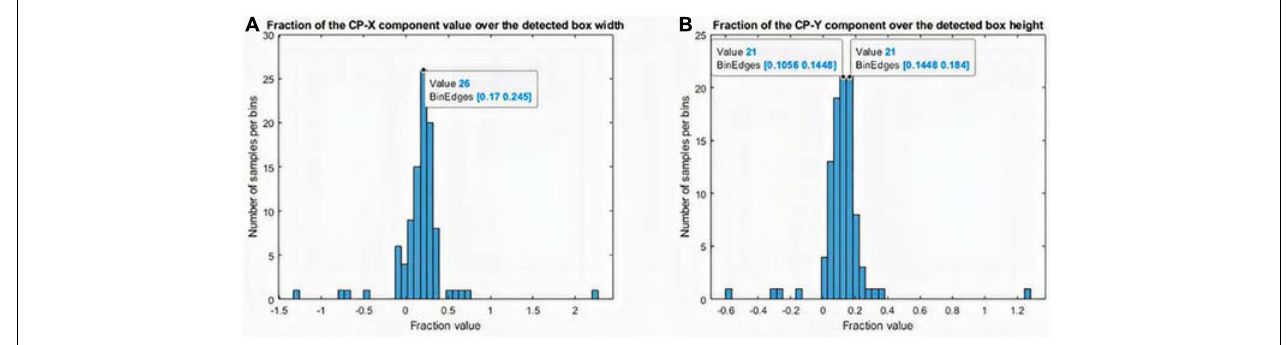
FIGURE 6 | Histogram of the behavior of the distance between the preauricular point and the closest point on the right ear. (A) x- component variation and (B) y -component variation.